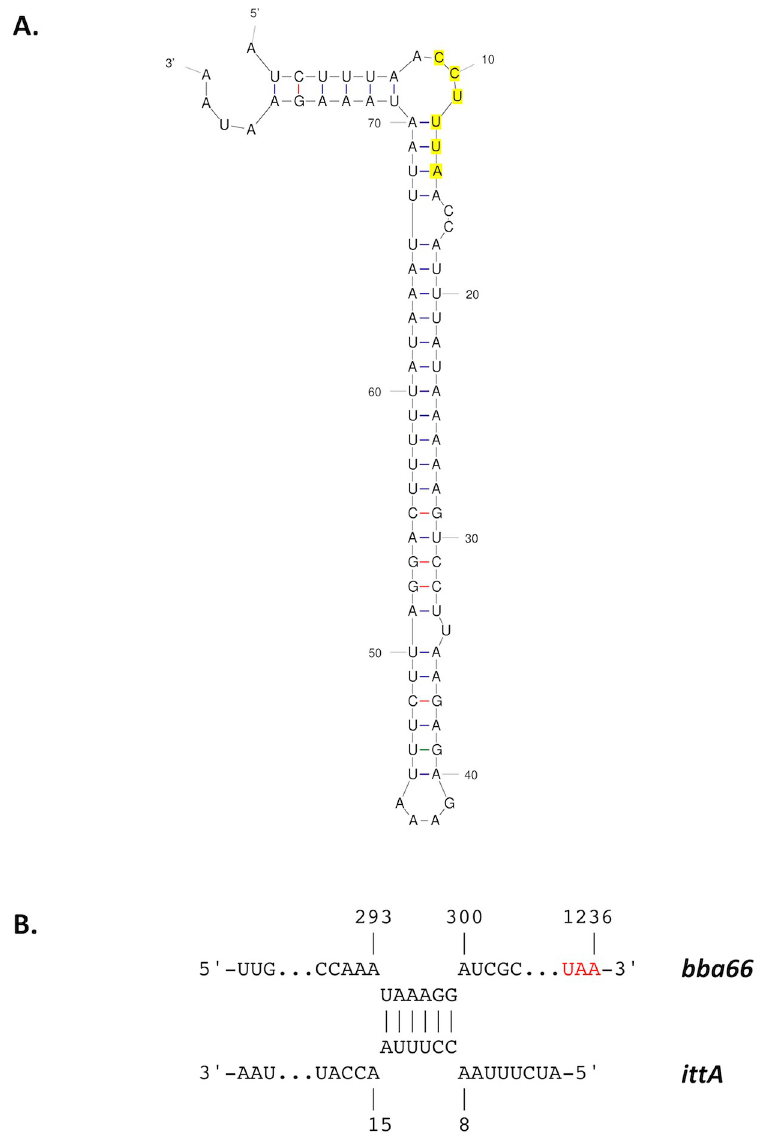
Fig 10. IntaRNA (Freiburg RNA Tools) predictions of interactions of the ittA sRNA with the bba66 transcript. A. A predicted secondary structure of the ittA sRNA (mfold). B. Potential interaction of the ittA sRNA (lower) within the coding sequence of bba66 (upper). The red depicts the bba66 stop